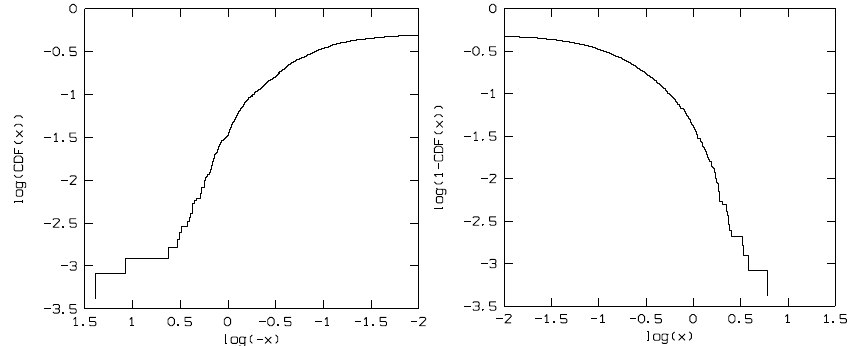
Figure 1. The double logarithmic graph of the cumulative distribution function (CDF). The left is the plot of the negative data set of X i , the right is the plot of the negative data set of X i